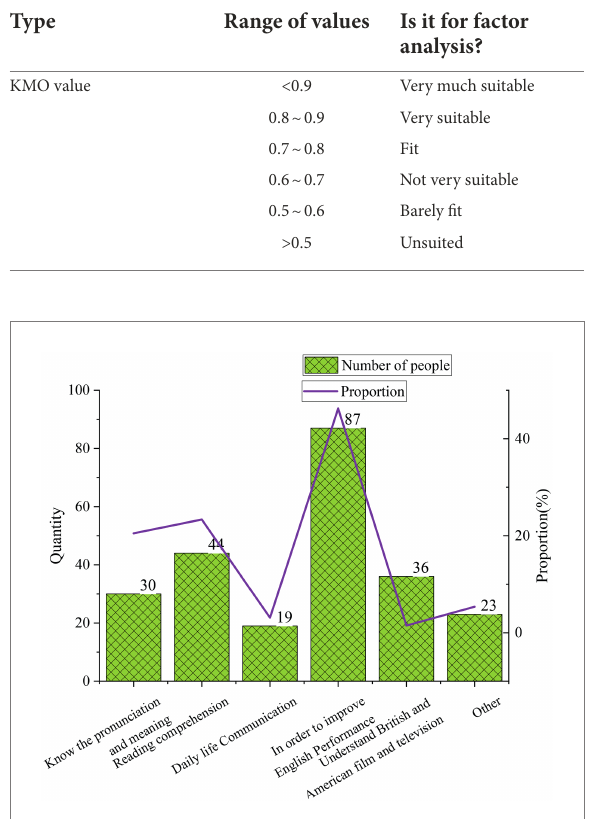
FIGURE 6 The purpose of learning English vocabulary for college